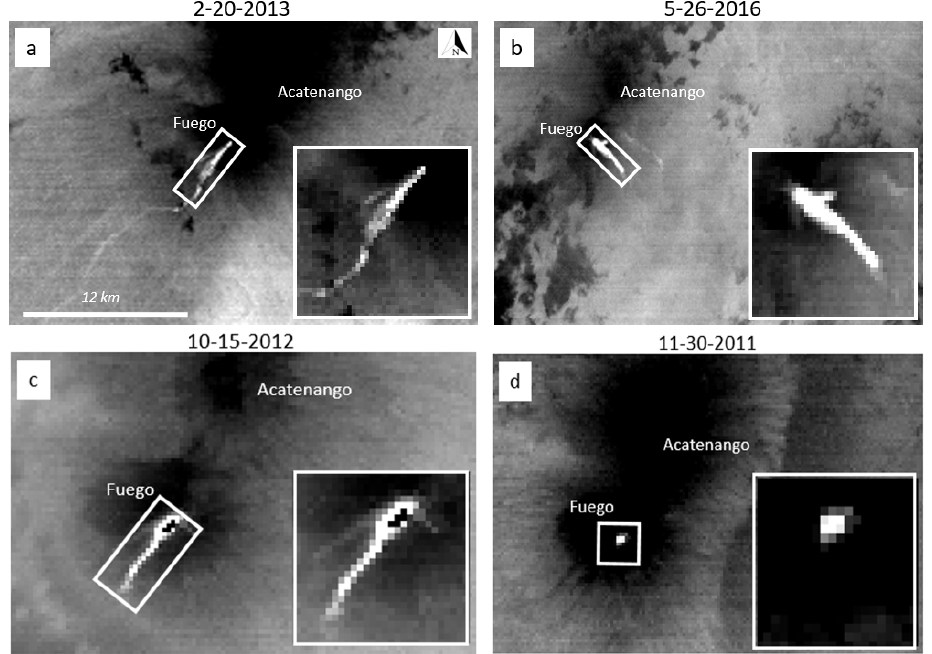
Figure 4. Examples of the Advanced Spaceborne Thermal Emission and Reflection Radiometer (ASTER) thermal infrared (TIR) nighttime surface kinetic temperature product used to investigate the volcanic activity at Fuego. The thermally-elevated regions show: ( a ) a PDC traveling to the SW down Cenizas barranca; ( b ) a PDC traveling to the SE down El Jute barranca. Other thermal anomalies seen in the data include: ( c ) a lava flow traveling down Cenizas barranca (note the black “recovery” pixels at the summit indicating adjacent saturated pixels); ( d ) a grouping of thermally elevated pixels at the summit most likely caused by open-vent or dome activity. Scene subsets ( a – c ) were validated using the INSIVUMEH reports to confirm the type of activity and direction traveled. See Figure 1 for the location of the named barrancas.